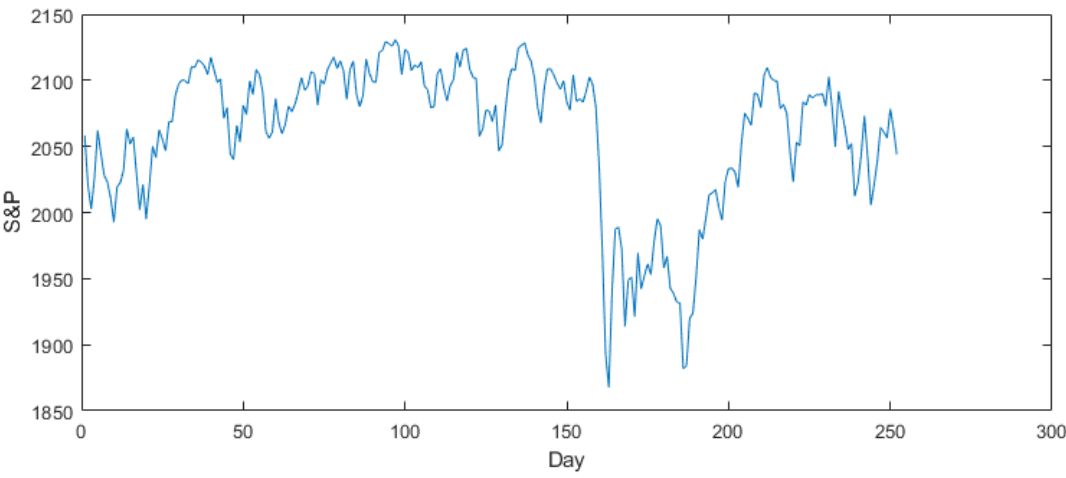
Figure 3. The time-series plot of the Stock and Price (S&P) dataset.